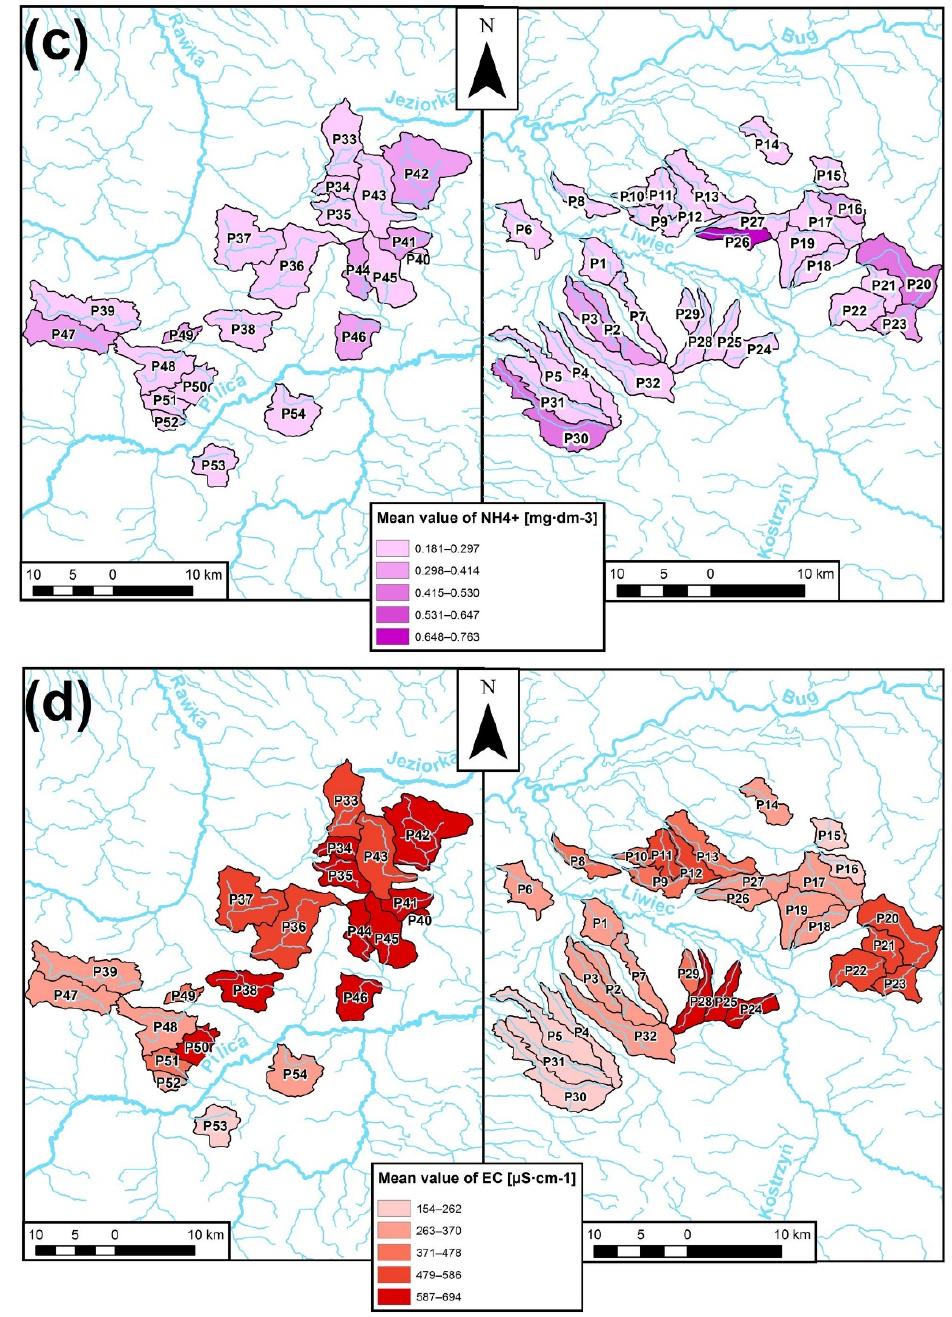
Figure 2. The spatial variability of NO 3 − ( a ), NO 2 − ( b ) and NH 4+ ( c ) concentrations, as well as EC values ( d ) in the investigated lowland streams .